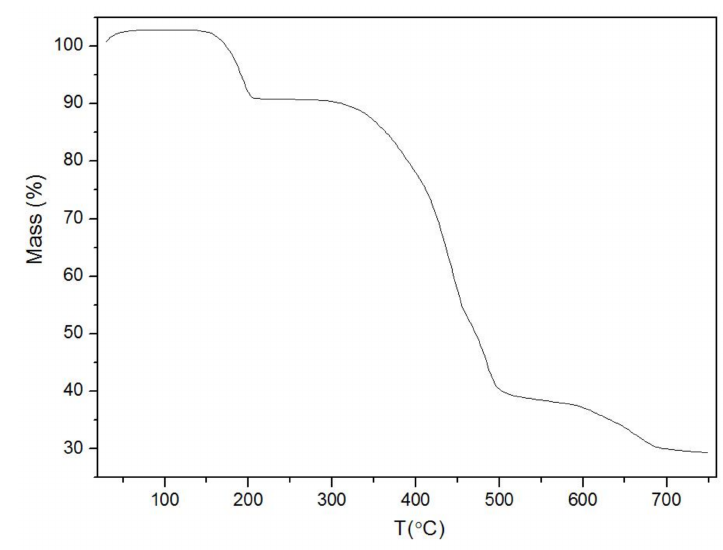
Figure 3. Thermal analysis of Fe-MOFs.